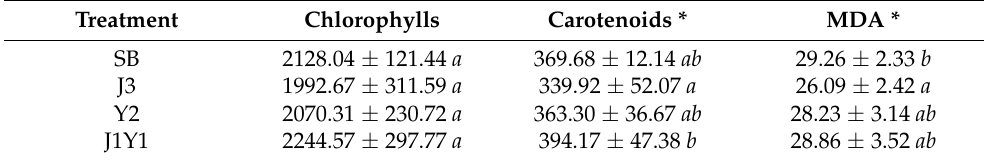
Table 2. Mean and standard deviation for the biochemical variables: total contents of chlorophylls ( µ g g − 1 FW), carotenoids ( µ g g − 1 FW), and malondialdehyde (MDA, nmol g − 1 FW). Treatments are biostimulant foliar applications (SB: Seedlings sprayed with only water, J3: seedlings sprayed with Larrea divaricate (3% w / v ), Y2: seedlings sprayed with Ilex paraguariensis (2% w / v ), and J1Y1: mixture of both biostimulants (1% w / v : 1% w / v ). Different letters indicate significant differences, according to LSD Fisher pairwise comparison procedure with α : 0.1. Stars indicate the significance level. Significance levels: **** <0.001; *** <0.01; ** <0.05; * < 0.1.